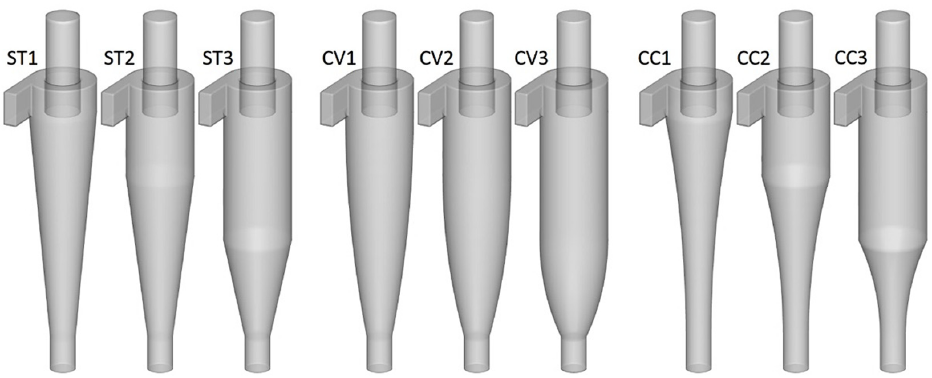
Figure 2. Structural representation of all the cyclone models of ST variant, CV variant and CC variant (from left to right), respectively.